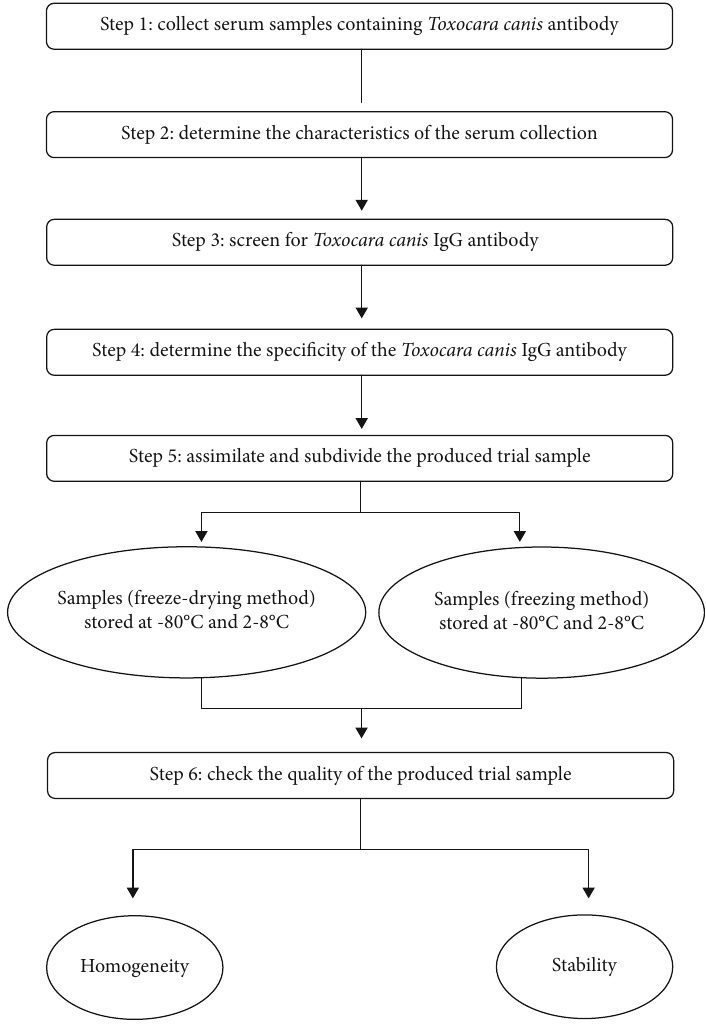
Figure 2: The work fl ow of preparation of trial samples containing an anti- Toxocara canis antibody used in